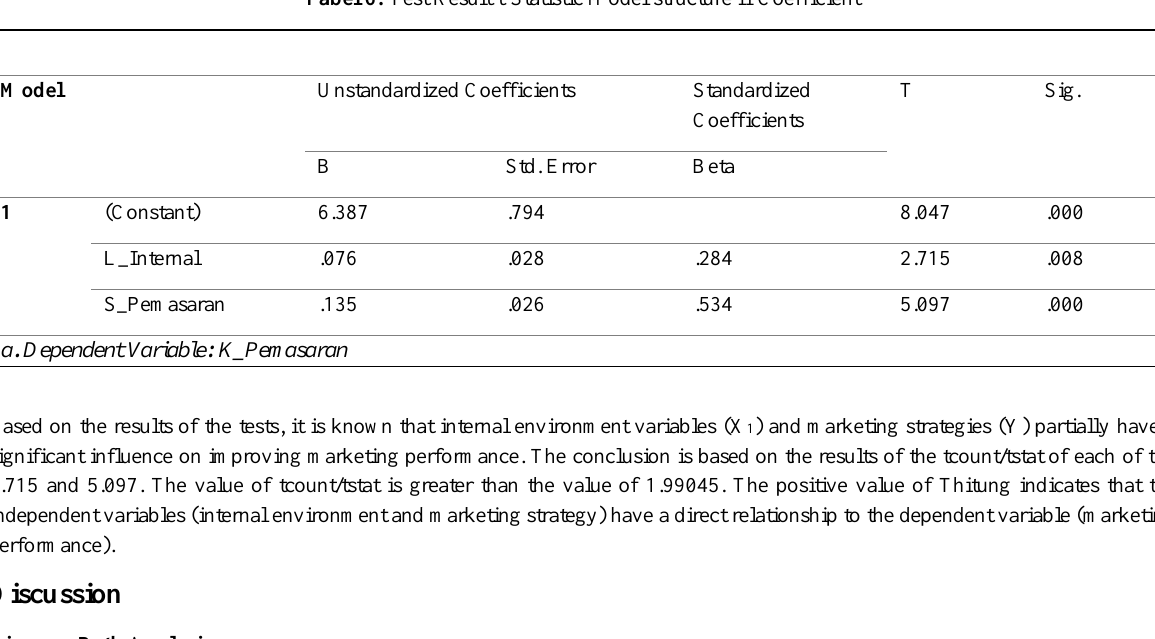
Tabel 6: Test Result t-Statistic Model structure II Coefficient